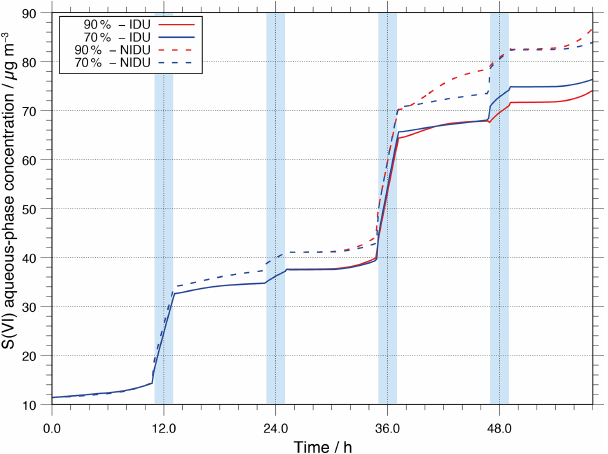
Figure 3. Modelled sulfur(VI) aqueous-phase concentration in µgm − 3 throughout the modelling time for the different urban simulation cases (90%-IDU / 90%-NIDU and 70%-IDU / 70%-